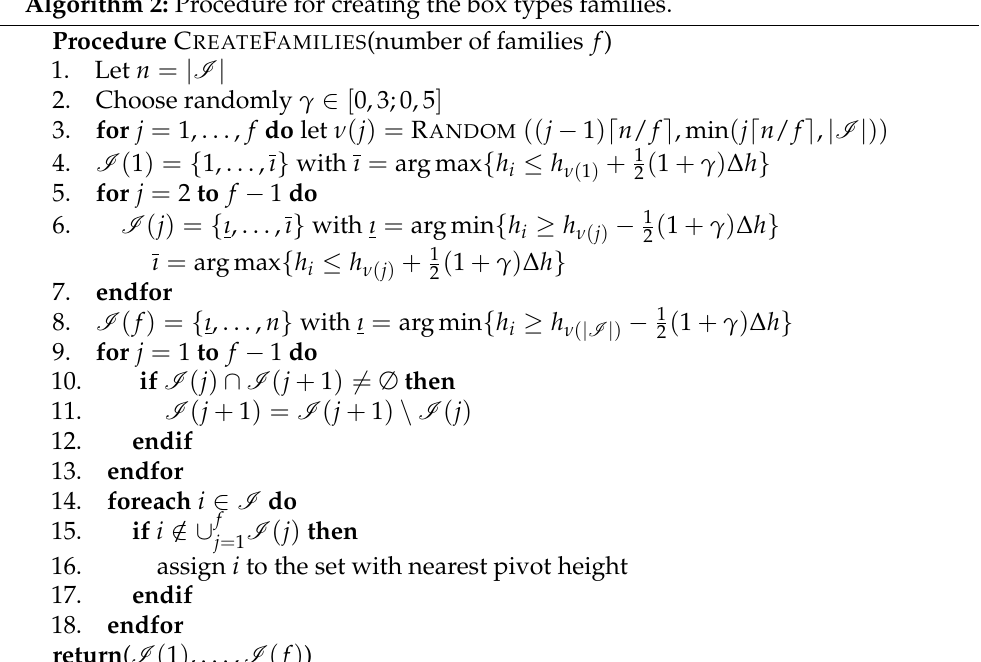
Algorithm 2: Procedure for creating the box types